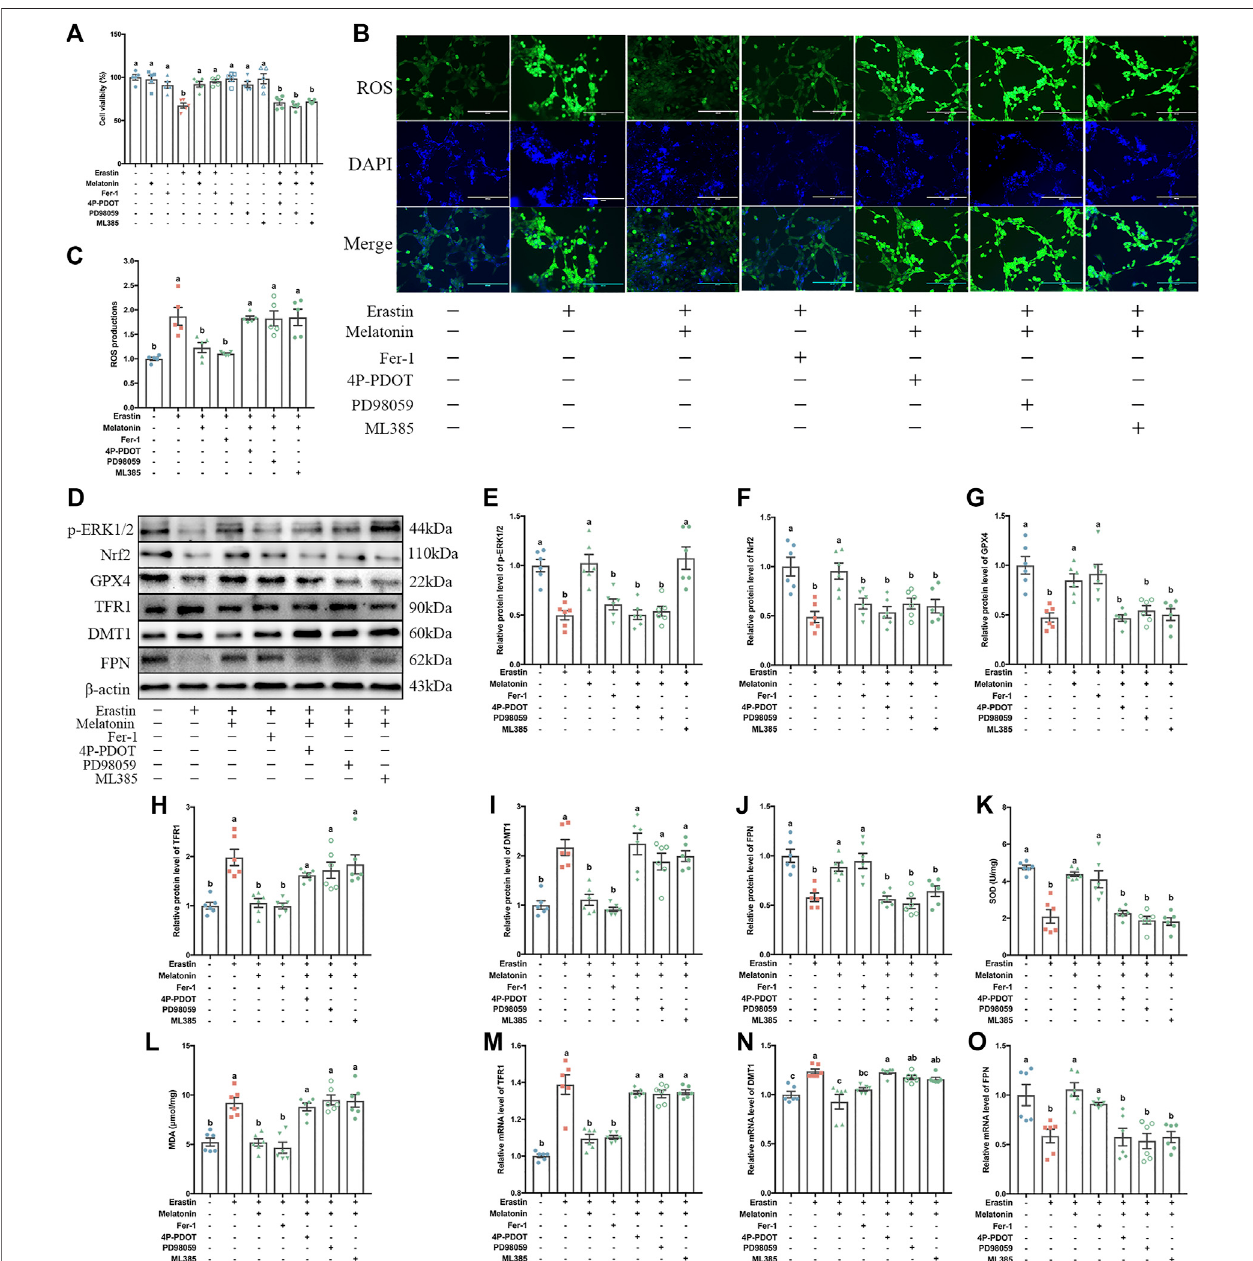
FIGURE 6 | Effect of melatonin on MT2/ERK/Nrf2 signaling in the HT-22 cells exposed to Erastin. The HT-22 cells exposed to Erastin and melatonin or Fer-1 were pretreated with 4P-PDOT, PD98059 and ML385, respectively. (A) Relative cell viability (%) ( n (cid:1) 5). (B) Fluorescence staining of ROS. Bar (cid:1) 200 μ m. (C) Relative quanti fi cationofintracellularROSlevel( n (cid:1) 5). (D – J) Relativeproteinlevelsof p -ERK1/2,Nrf2,GPX4,TFR1,DMT1andFPNnormalizedto β -actin( n (cid:1) 6). (K – L) SODand MDA levels ( n (cid:1) 6). (M – O) RelativemRNA levelsofirontransporterproteins(TFR1,DMT1and FPN) ( n (cid:1) 6). Differences wereassessed using one-way ANOVA. The result representsthe mean ± standard error ofthemean. Values notsharingacommon superscript letter differ signi fi cantlyat p < 0.05; thosewith thesameletter do not differ signi fi cantly ( p ≥ 0.05).